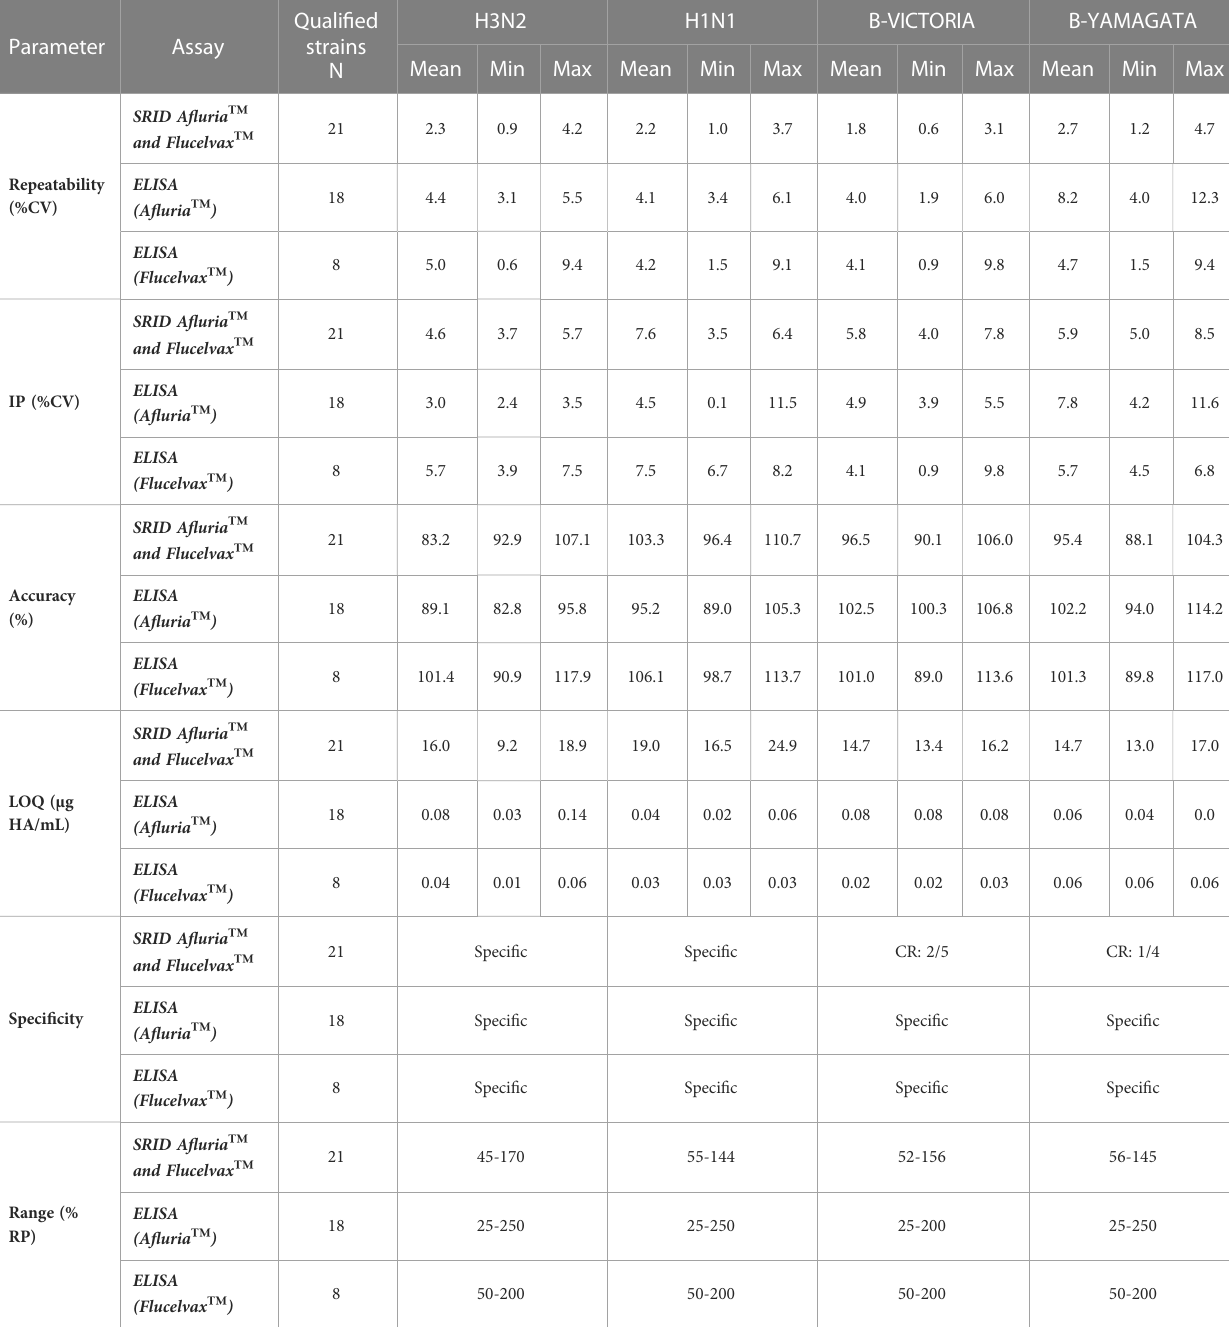
TABLE 5 Summary of ELISA and SRID assay quali fi cation for egg and cell derived quadravalent vaccine (A fl uria ™ and Flucelvax ™ respectively).